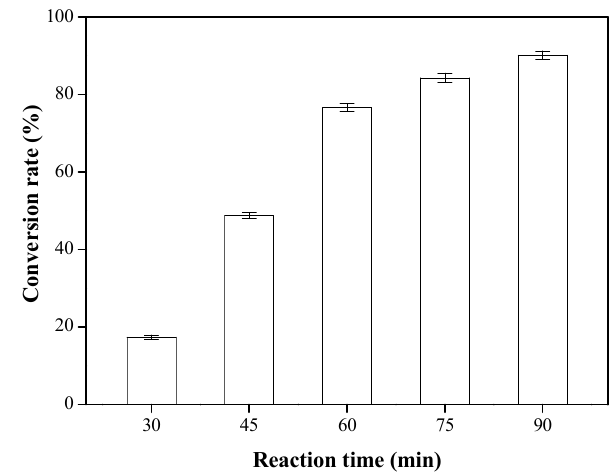
Figure 8. Effect of reaction time on the transesterification reaction. Reaction conditions: methanol-to-oil molar ratio: 6:1; catalyst amount: 4 wt %; rotation speed: 7000 rpm; reaction temperature: 65 °C; reaction time: 30–90 min.